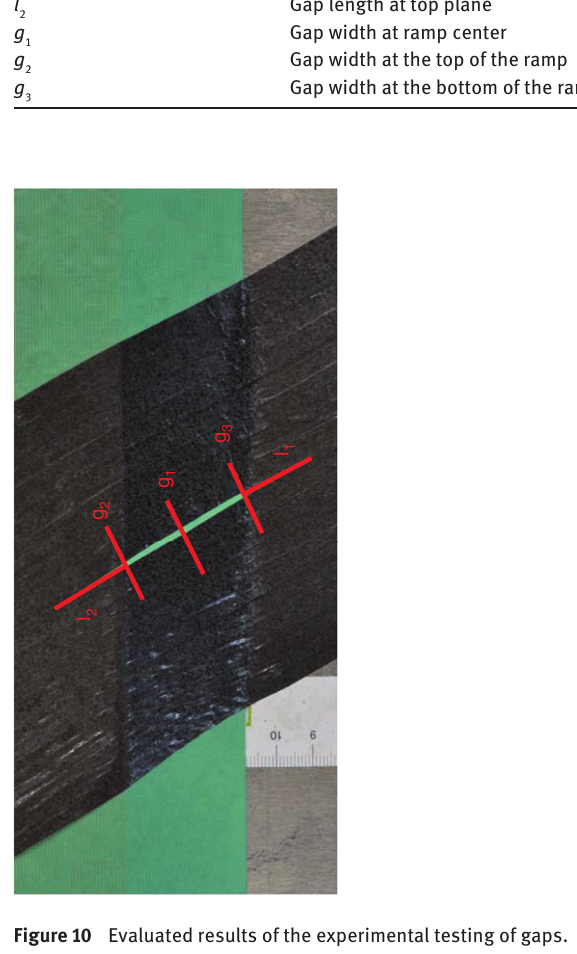
Figure 14 Parallel offset due to geodesic path generation.